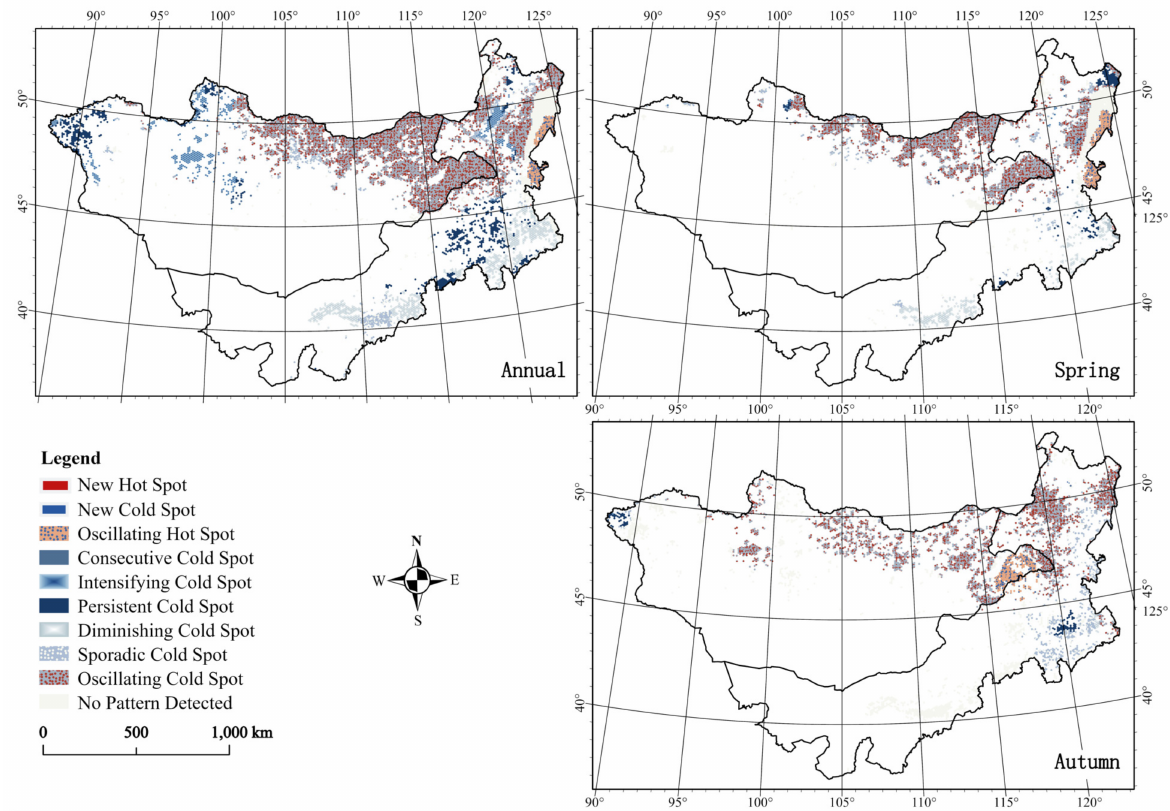
Figure 6. Wildfire pattern changing trend during 2001 to